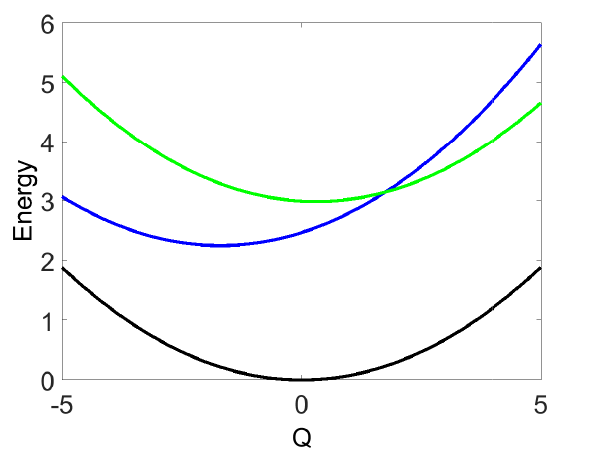
Figure 1. Sketch of the potential-energy functions of the chromophore with the electronic ground state | e (cid:105) (black) and coupled excited electronic states | e 0